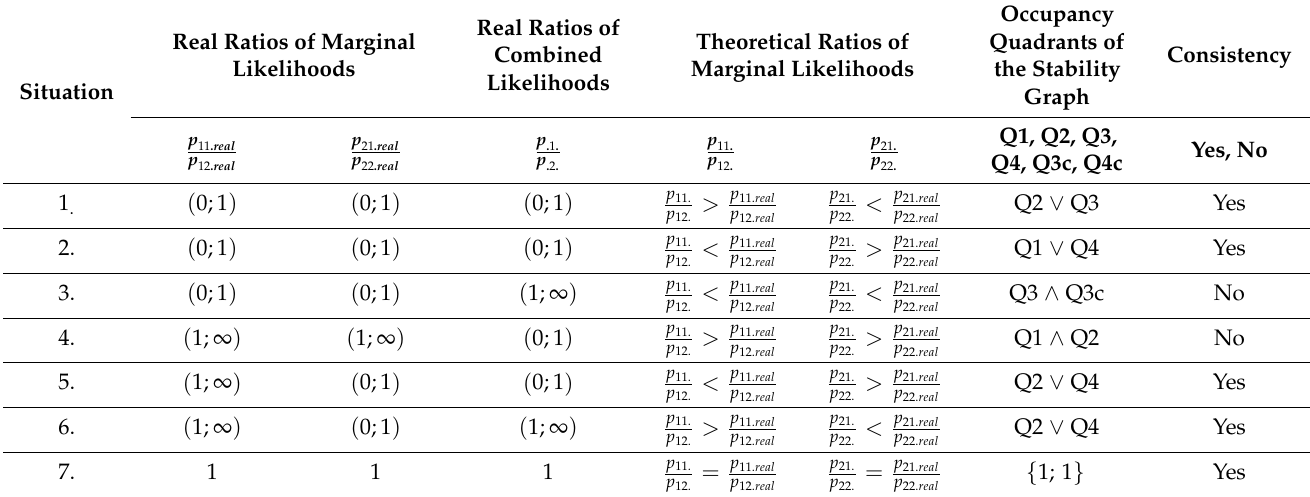
Table 2. Combinational consistency of data subgroups and merged